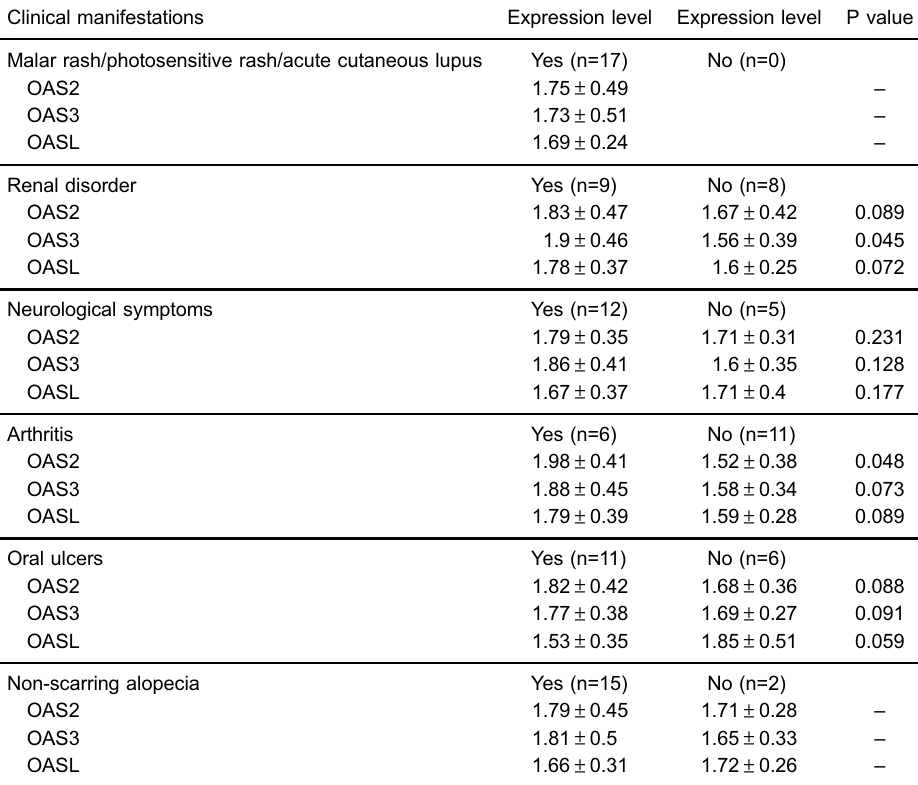
Table 6. Association of OAS2, OAS3, and OASL expression in CD4 + T cells with systemic lupus erythematosus manifestations. Clinical